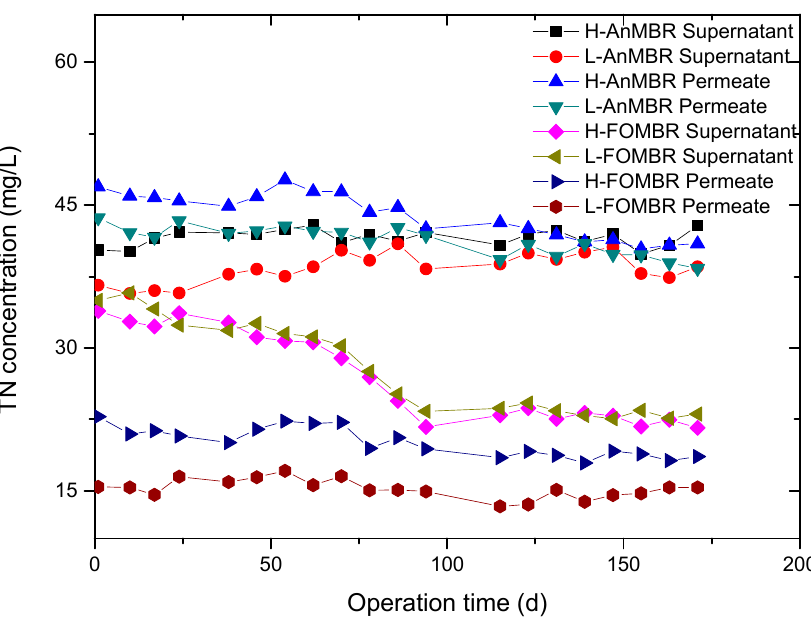
Figure 5. The evolution of total nitrogen (TN) concentrations in the H-AnMBR and L-AnMBR and the H-FOMBR and L-FOMBR.